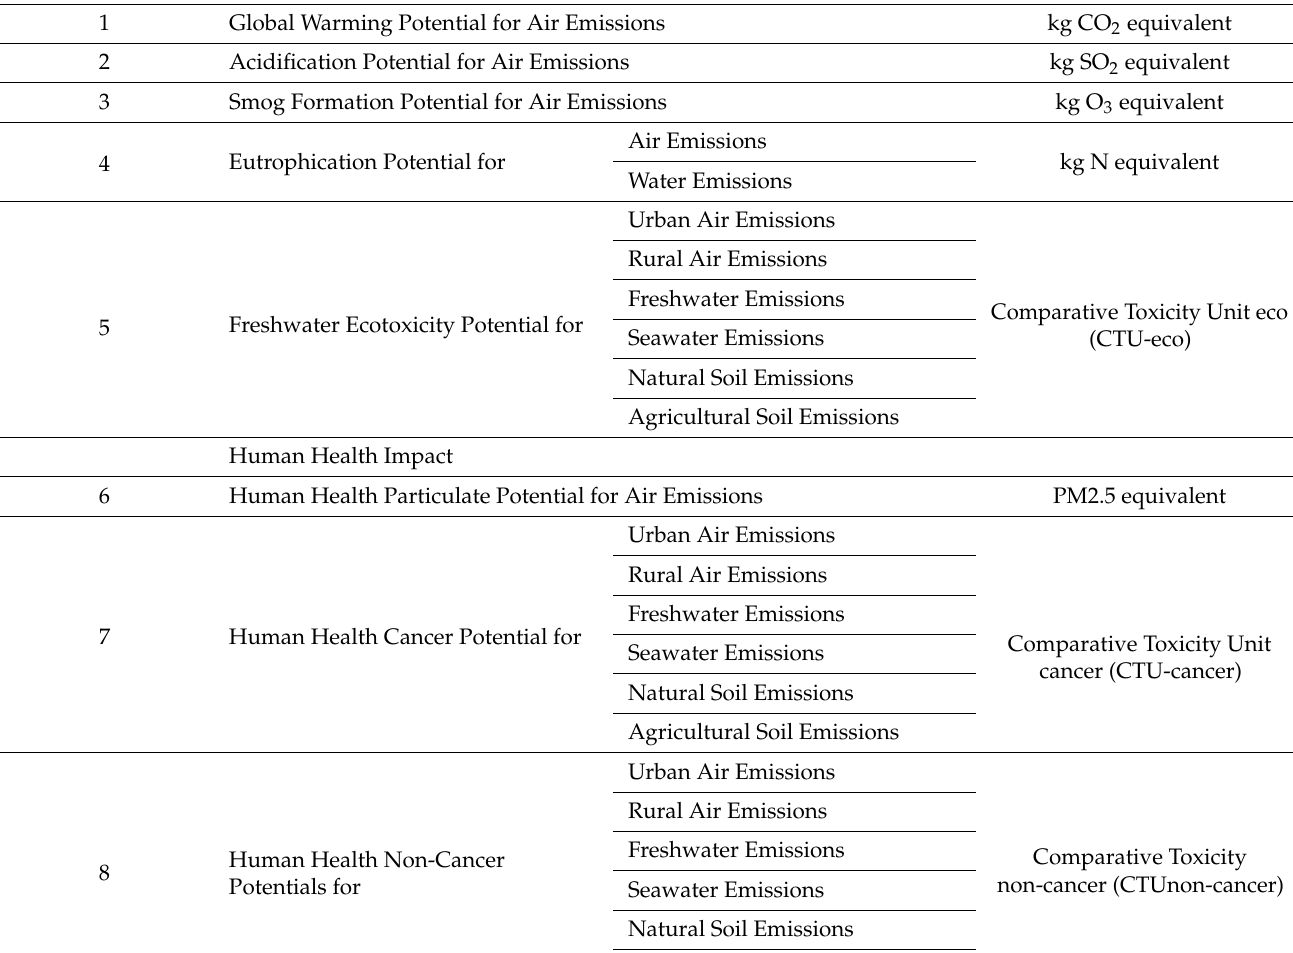
Table 1. Environmental and human health impact